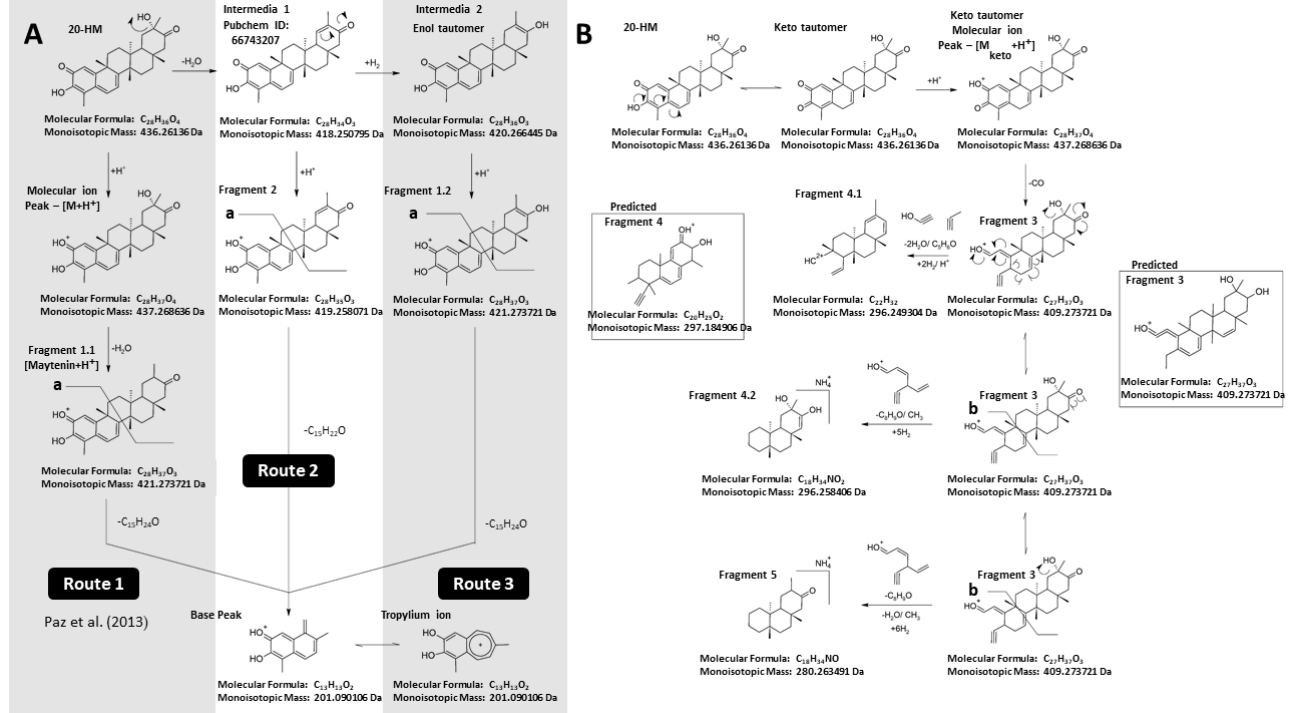
Figure 2. Proposed mass fragmentation scheme of 20-HM from a previous study and the PubChem database of 20-HM derivatives ( A ); proposed mass fragments by adopting CFM-ID program version 3.0 prediction ( B ). The predicted fragments of 20-HM from the CFM-ID program are shown in the boxes. (see Supplementary Material, Figure S4).